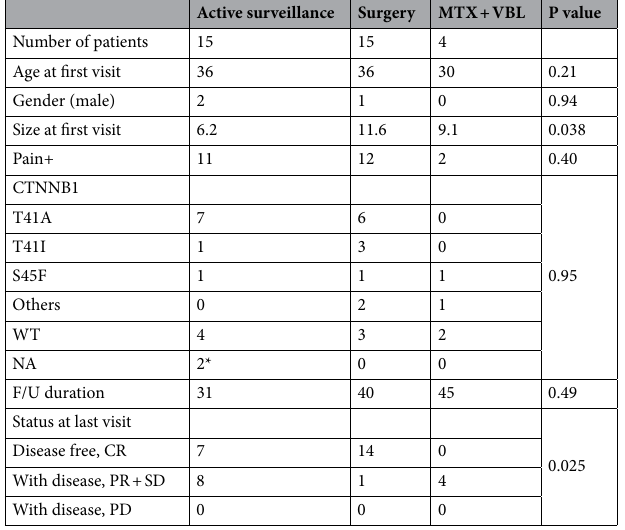
Table 3. Comparison between active surveillance only, surgery, and MTX + VBL treatment group. Age, size, F/U median value, MTX methotrexate, VBL vinblastine, WT wild type, F/U median follow up, duration from first visit to last visit, CR complete remission, PR partial remission, SD stable disease, PD progressive disease. *2 cases were excluded due to the low quality of